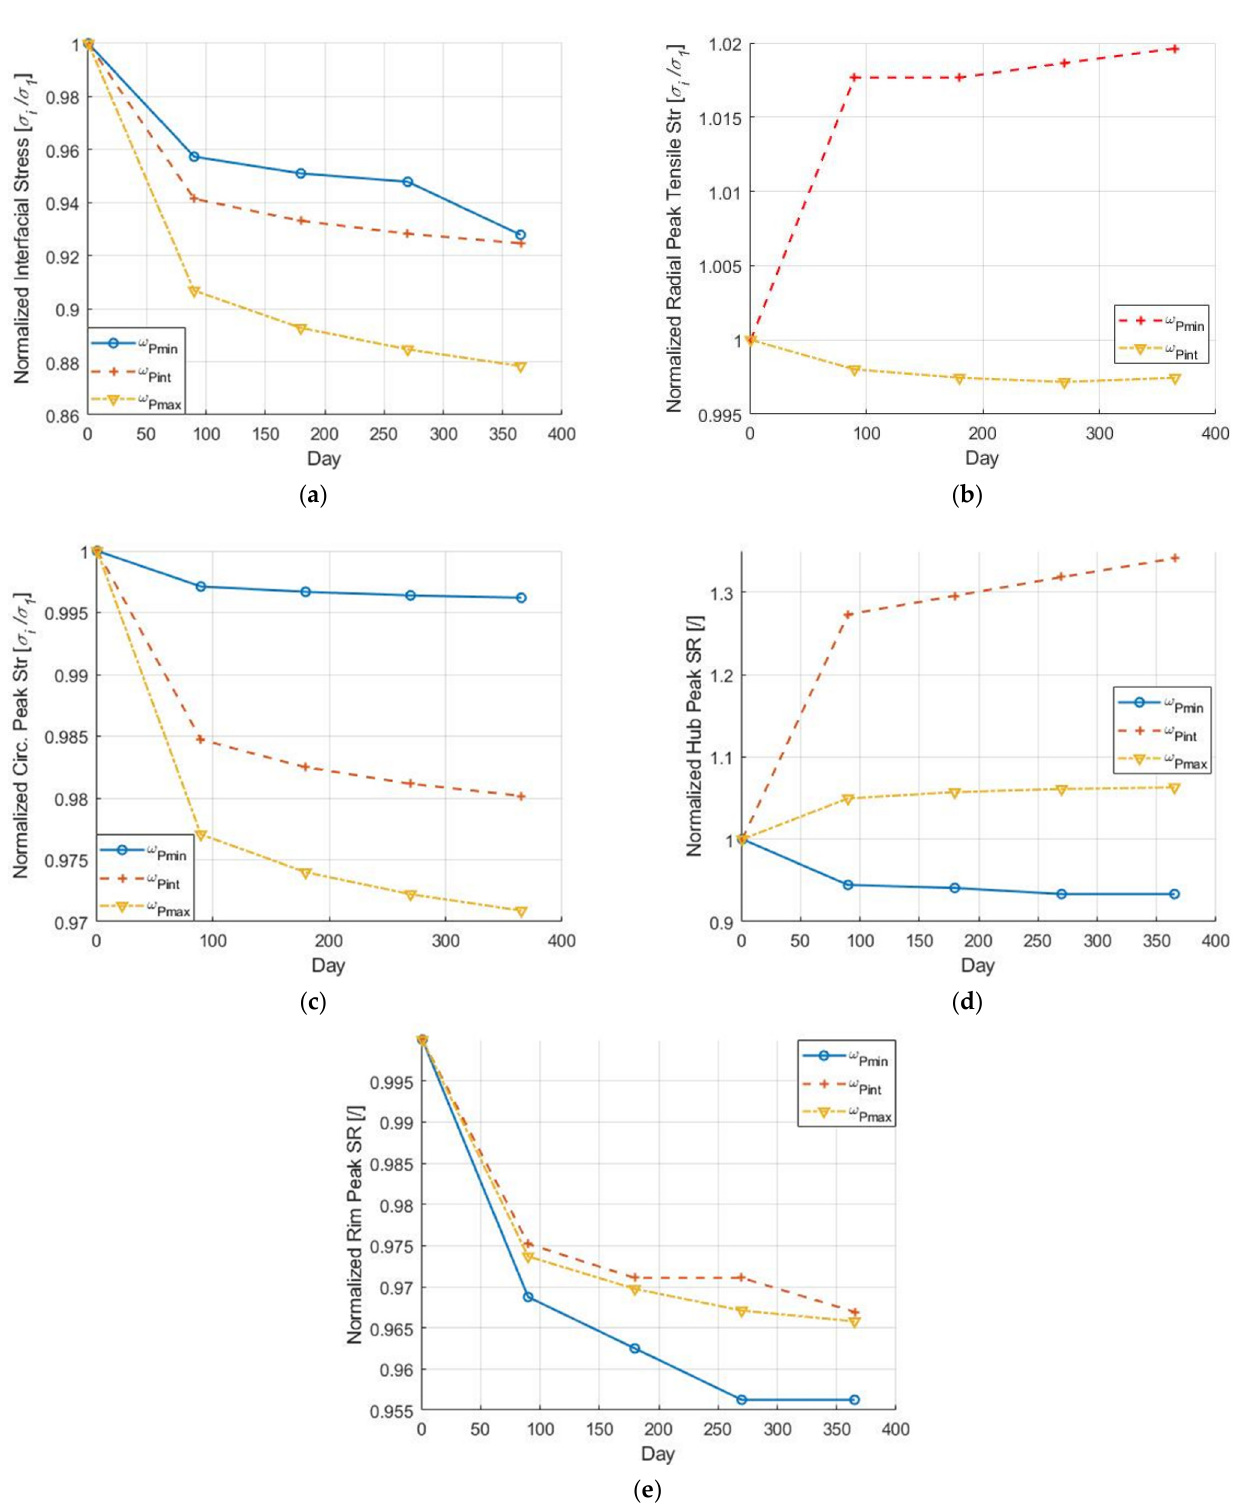
Figure 8. Stress results normalized by their initial value on day 1 for ( a ) interfacial pressure, ( b ) peak radial tensile stress, and ( c ) peak circumferential stress in the CFRP rim, ( d ) peak SR in the aluminum hub, and ( e ) peak SR in the CFRP rim.